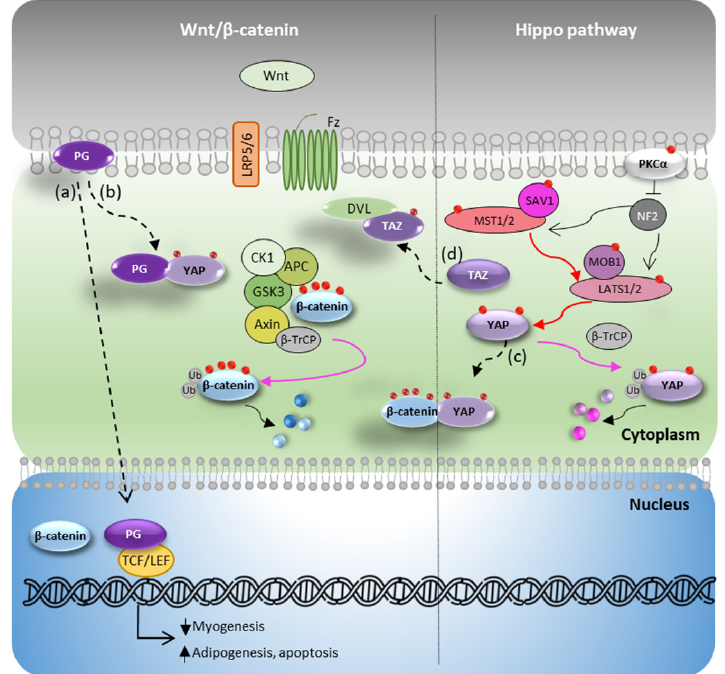
Figure 3. Interconnection between Wnt/ β -catenin and Hippo pathways in the pathologic ACM scenario. ( a ) Free plakoglobin translocates into the nucleus and competes with β -catenin to bind the transcription factors TFC/LEF, although in a weaker manner, thus producing a shift from myogenic to adipogenic cell phenotype; ( b ) Free plakoglobin binds and blocks phospho-YAP, impairing its degradation; ( c ) phospho-YAP binds phospho- β -catenin, avoiding its ubiquitination; ( d ) phospho-TAZ binds Dvl, blocks β -catenin translocation to the nucleus, and impairs gene transcription. APC: adenomatous polyposis coli; β -TrCP: beta-transducin repeat containing E3 ubiquitin protein ligase; CK1: casein kinase 1; GSK3 β : glycogen synthase kinase-3 beta; SAV1: Salvador1; MST1/2: Ste20-like kinase 1/2; MOB1: monopolar spindle-one-binder protein 1; PG: Plakoglobin; LATS1/2: large tumor suppressor kinase 1/2; NF2: neurofibromatosis type 2; TAZ: transcriptional coactivator with PDZ-binding motif; Ub: ubiquitination marks; YAP: Yes-associated protein. Discontinuous arrows indicate pathological ACM situations.